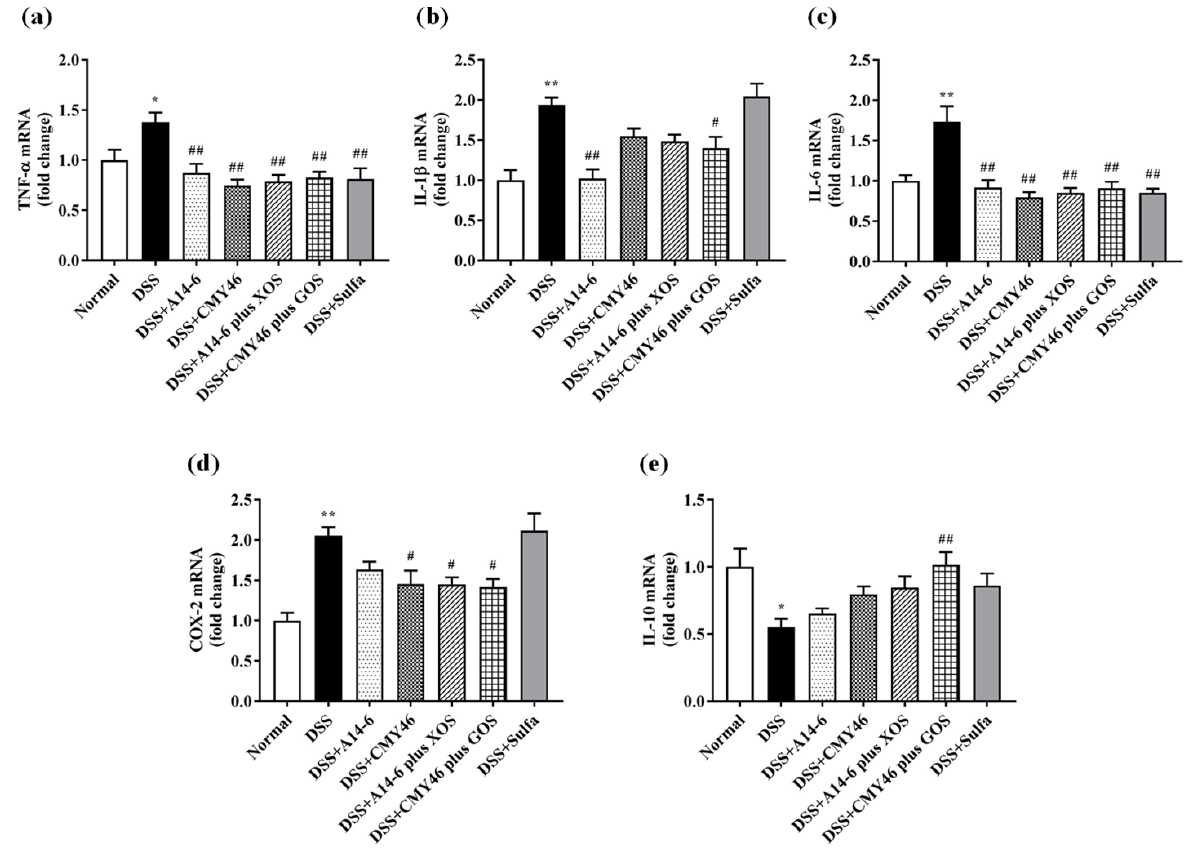
Figure 6. The effect of probiotics and synbiotics from Miang suppressed DSS-induced colonic inflammation. The expression levels of ( a )TNF- α ; ( b ) IL-1 β ; ( c ) IL-6; ( d ) COX-2; and ( e ) IL-10. Data expressed as mean ± SEM ( n = 7), * p < 0.05; ** p < 0.01 vs. normal group. # p < 0.05; ## p < 0.01 vs. DSS group.